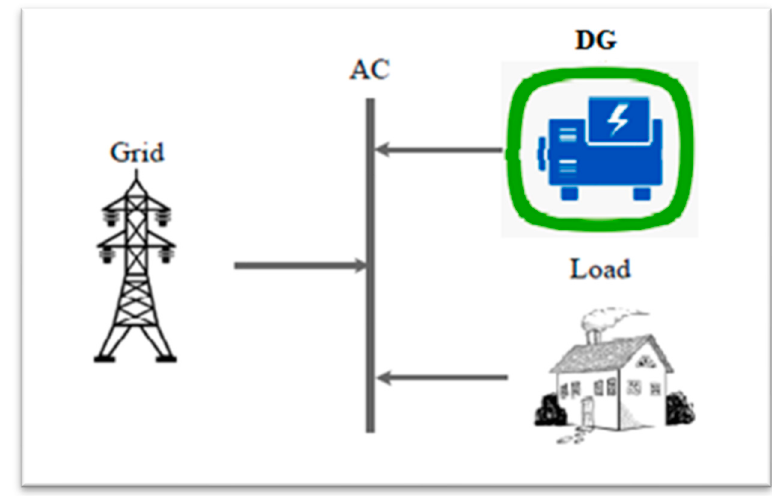
Figure 9. System 1: Grid-connected load with a backup power system.